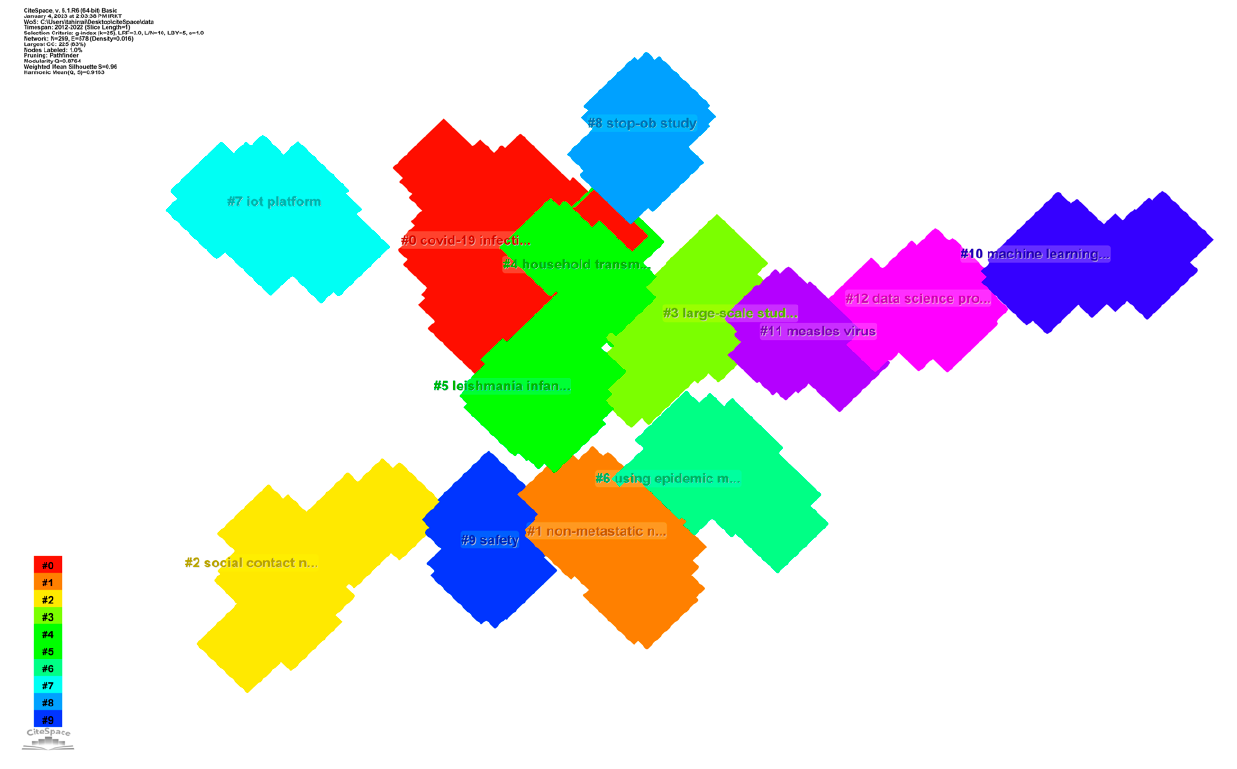
Figure 11. Top 12 co-cited reference clusters of studies of epidemic control based on big data research. Table 10. A brief summary of the top 12 clusters.